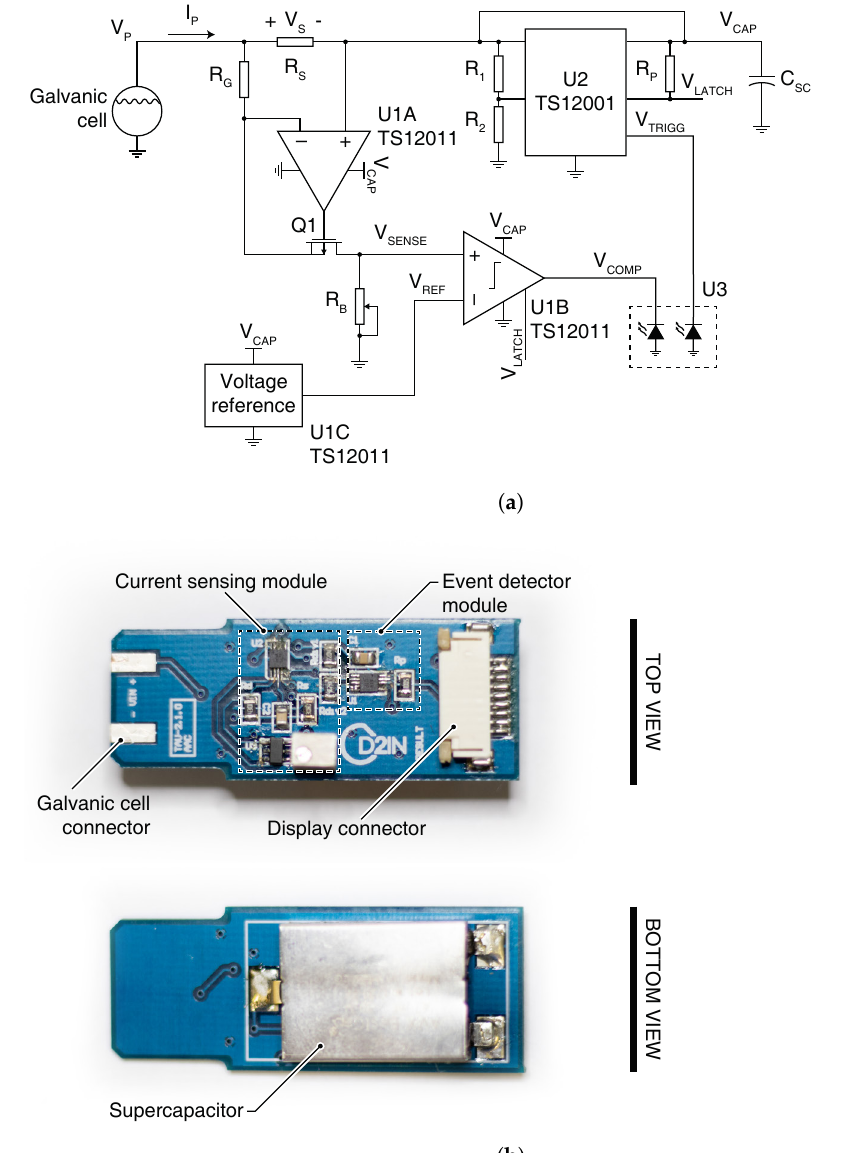
Figure 2. ( a ) Schematic of the implemented self-powered point-of-care device. ( b ) Picture of the implemented self-powered point-of-care